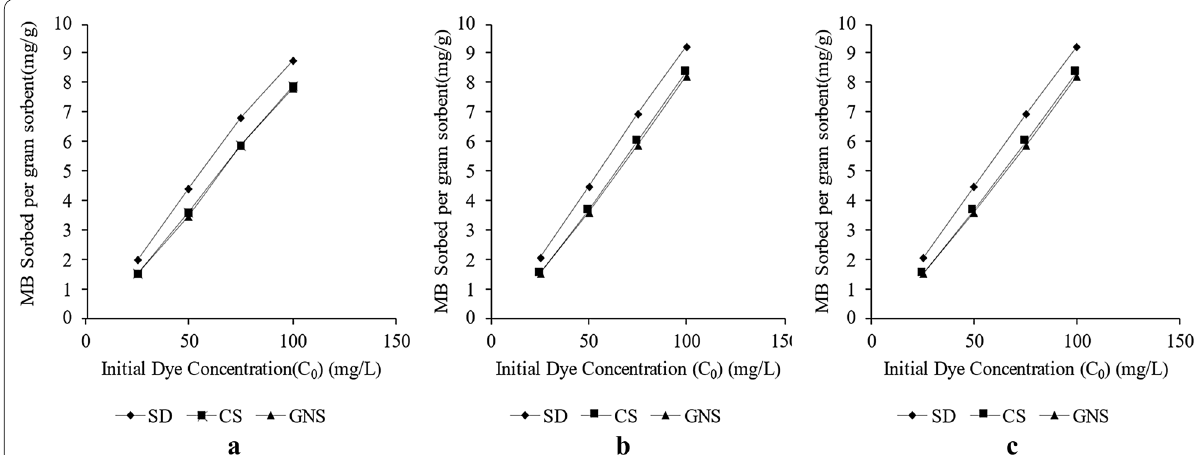
Fig. 3 a Impact of initial dye concentration on dye removal at 30 °C for SD, CS and GNS; b Impact of initial dye concentration on dye removal at 45 °C for SD, CS and GNS; c Impact of initial dye concentration on MB removal at 60 °C for SD, CS and GNS